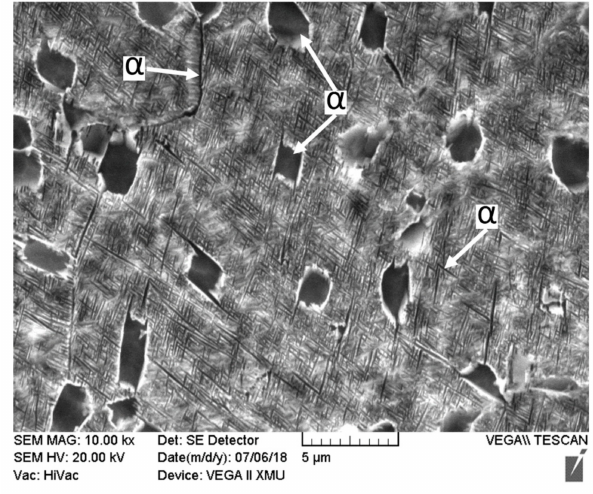
Figure 5. Microstructure of base metal of Ti55531